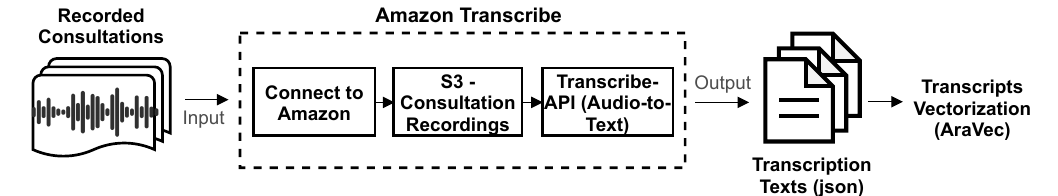
Figure 7. The process of converting the acoustic recordings into text and then extracting text-based features using